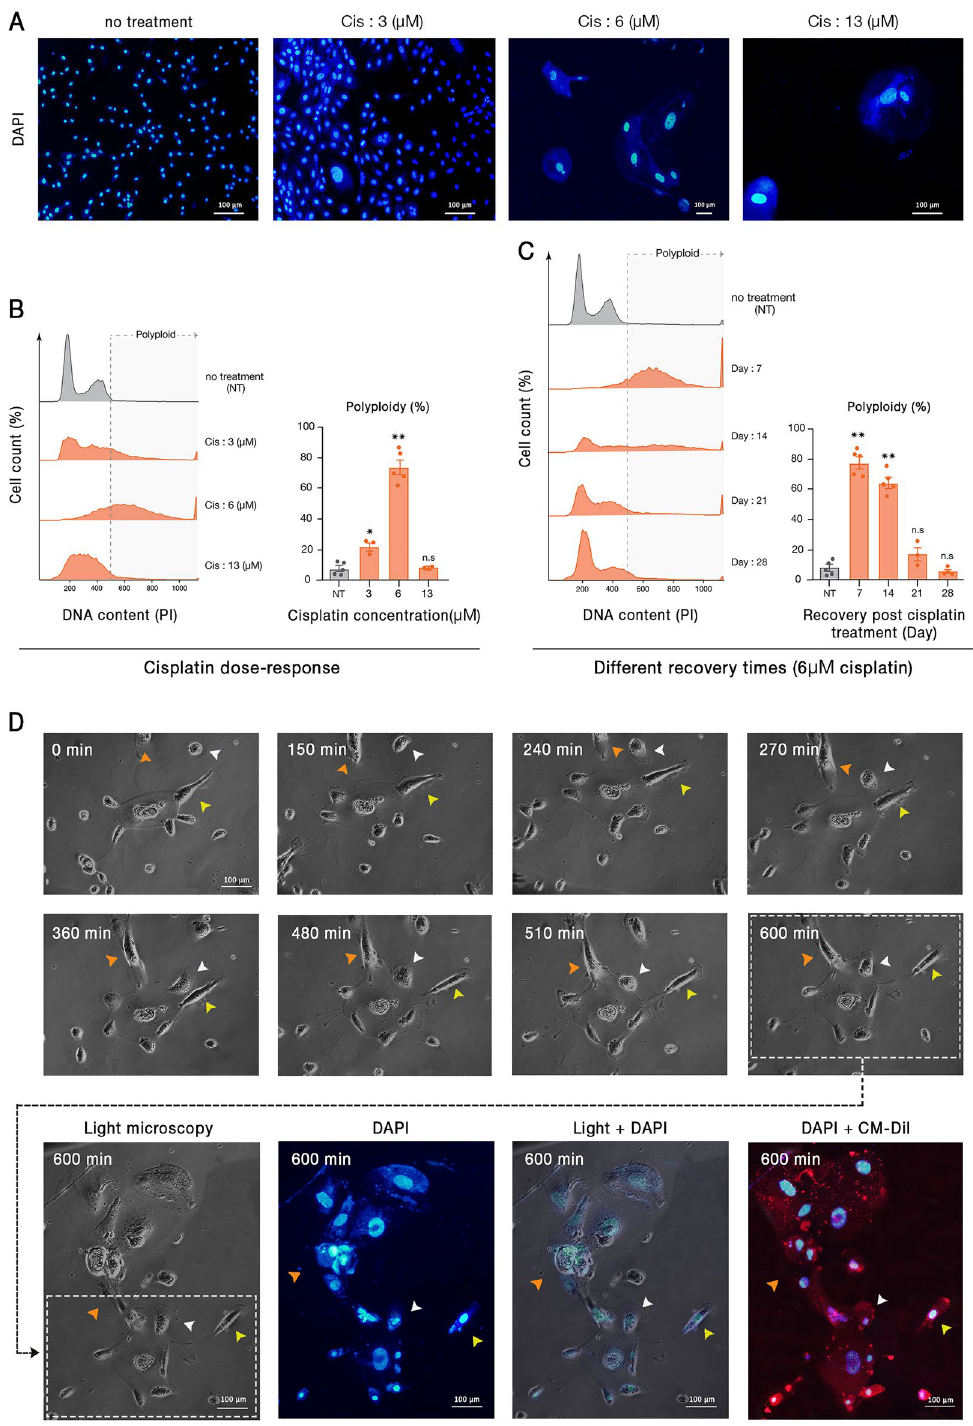
Figure 1. Cisplatin-induced polyploid cells demonstrate a dynamic polyploidization and depolyploidization characteristic. Cisplatin administration resulted in significant cell death and the enrichment of large polyploid cells. ( A ) Representative images of cells treated with 3, 6, and 13 μM cisplatin for 72 h are shown. In this panel, all pictures are captured with 20X objective lens except the third one (Cis 6 μM) which is taken with 10X. ( B ) DNA content analysis of treated cells with different doses of cisplatin indicated that the 6 μM cisplatin results in the highest rate of polyploidy. ( C ) Assessment of different recovery periods following the three days of 6 μM cisplatin administration revealed that polyploidy is maximal with a 7 days recovery time. ( D ) Time-lapse imaging of cisplatin-treated PGCCs demonstrated considerable changes in the genome content and cytoplasm morphology. White arrowheads: fusion with a diploid cell; orange arrowheads: fusion with another PGCC; yellow arrowheads: budding of daughter cells. Nuclei and cell membrane are stained with DAPI and CM-Dil, respectively; Cis: Cisplatin; * p- value < 0.05; ** p- value < 0.01; error bars: mean ±